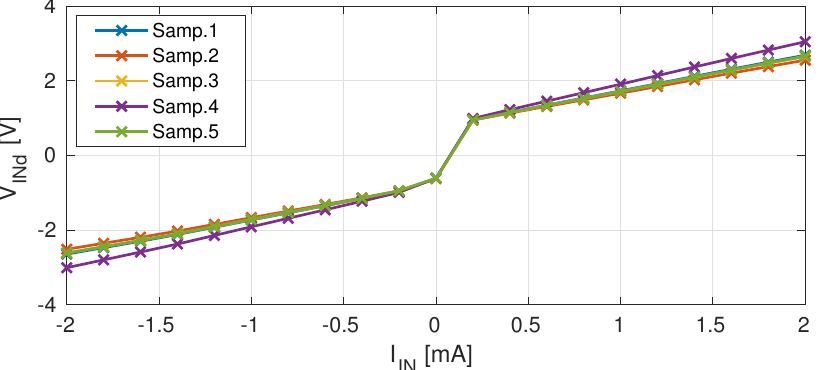
Figure 16. Measured differential input voltage V INd of the interface circuit for inductive speed sensors in Figure 9, with forced input current I IN .